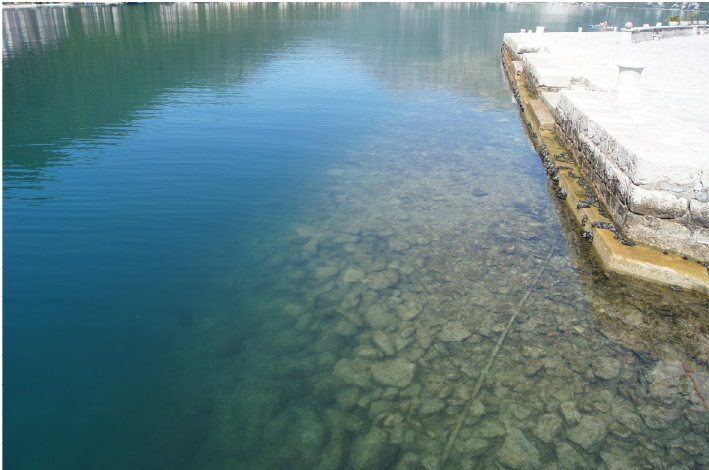
Figure 6. Stones around the Island of the Madonna of the Reef in 2021. Photo by author.